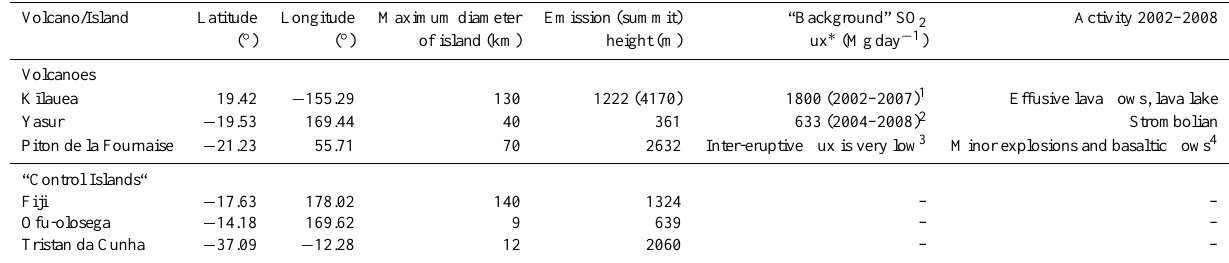
Table 1. Location, physical properties, degassing flux and eruptive character for volcanoes and “control” islands discussed in this study. Volcano/Island Latitude Longitude Maximum diameter Emission (summit) “Background” SO 2 ( ◦ ) of island (km) height (m) flux ∗ (Mgday − 1 ) Volcanoes K¯ılauea